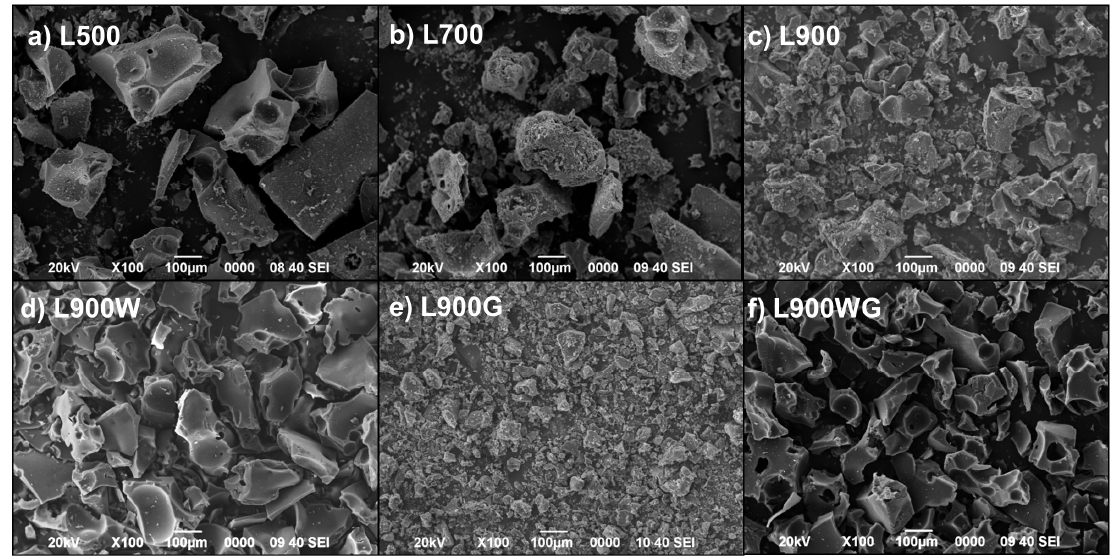
Figure 2. SEM micrographs of the different carbon catalysts. ( a ) L500; ( b ) L700; ( c ) L900; ( d ) L900W; ( e ) L900G; ( f ) L900WG.